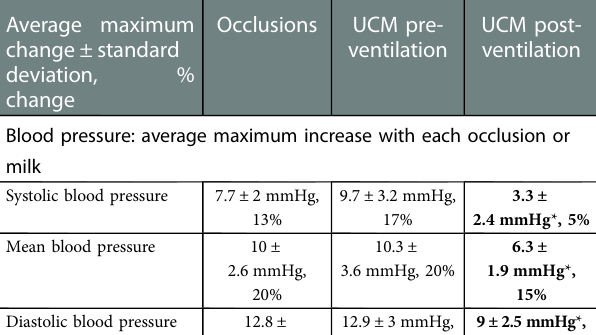
TABLE 2 Average maximum changes in blood pressure (measured in the carotid artery) and blood fl ow with each umbilical cord occlusion or umbilical cord milk (UCM) and compared between